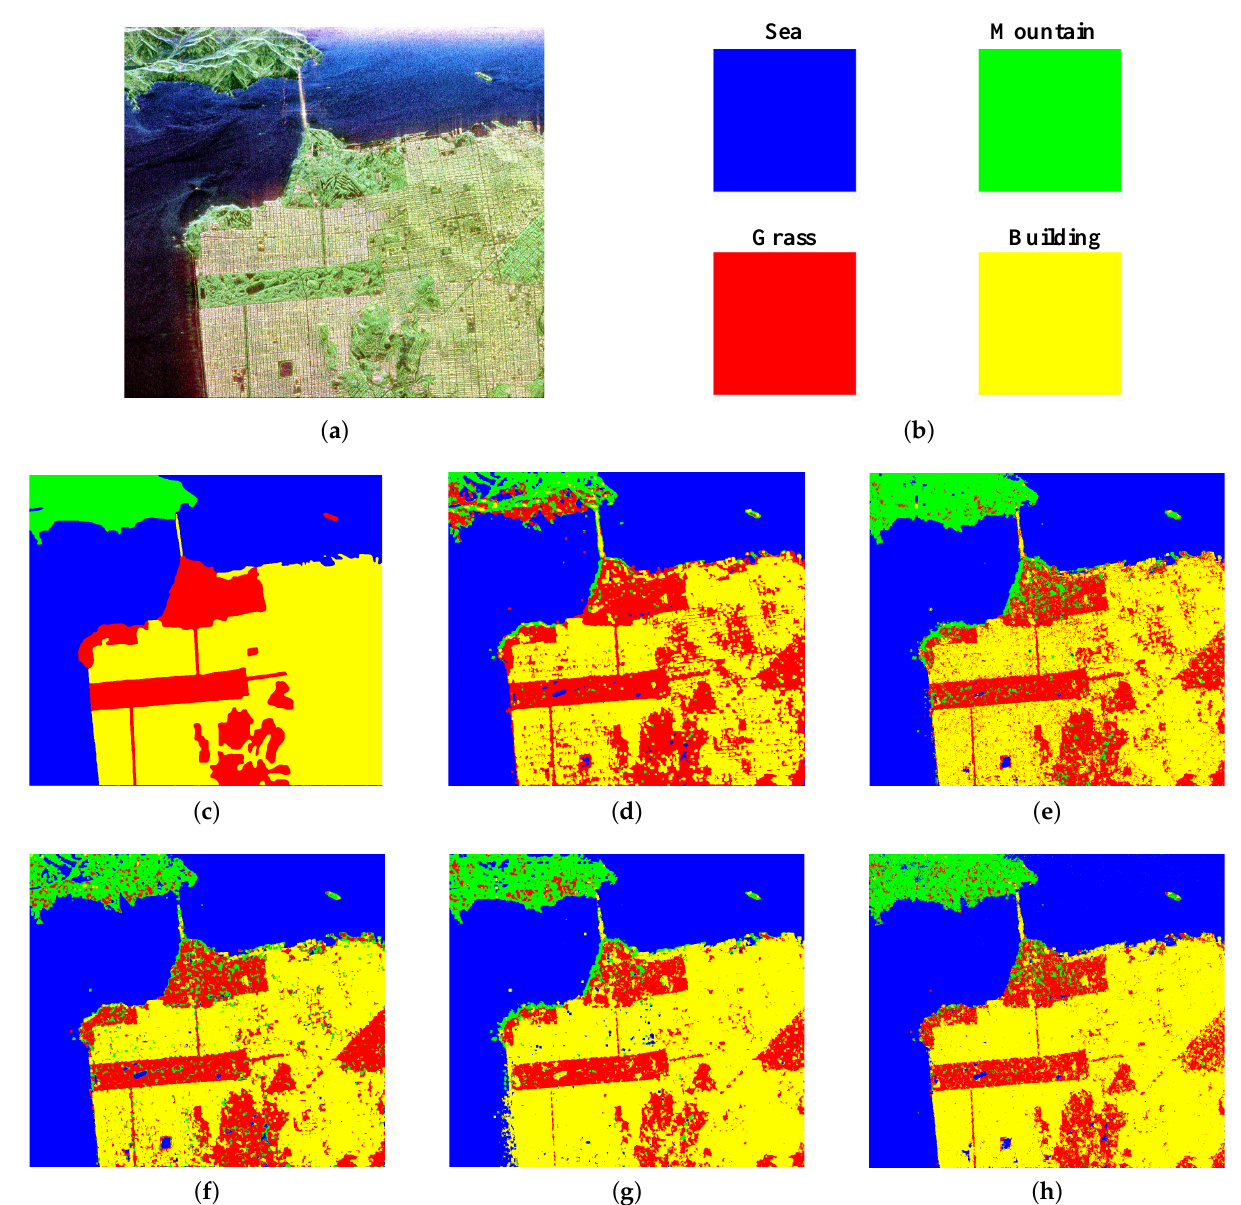
Figure 7. AIRSAR L-band PolSAR image of SanFransco. ( a ) Pauli RGB composite image for the original data. ( b ) Color code. ( c ) Ground truth map. ( d ) Result of Wishart-ML method. ( e ) Result of LE-NDR method. ( f ) Result of ND-KSVD method. ( g ) Result of RSC-SVM method. ( h ) result of